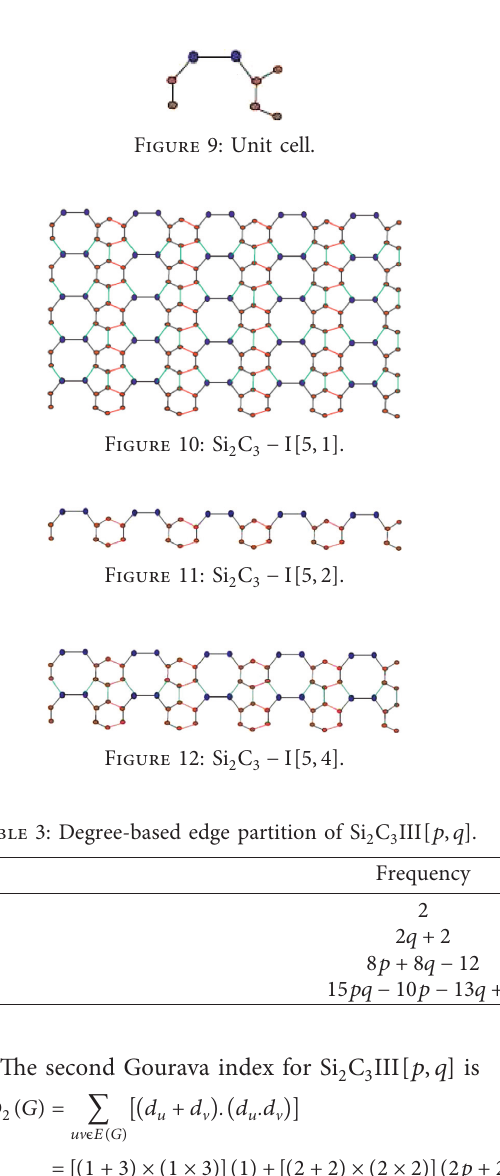
Figure 9: Unit cell.